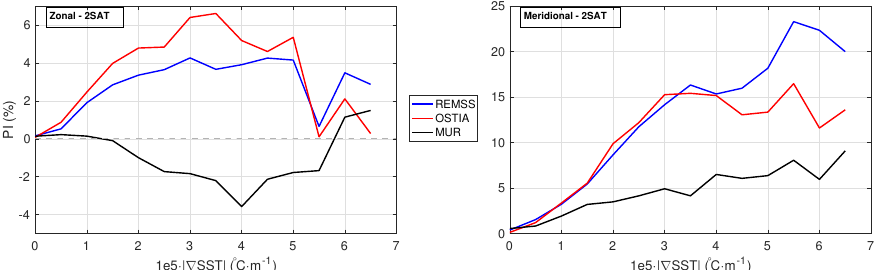
Figure 4. PI as a function of the local |∇ SST | for the zonal and meridional OPC. Red: OPC with REMSS SST; Blue: OPC with OSTIA SST; Black: OPC with MUR